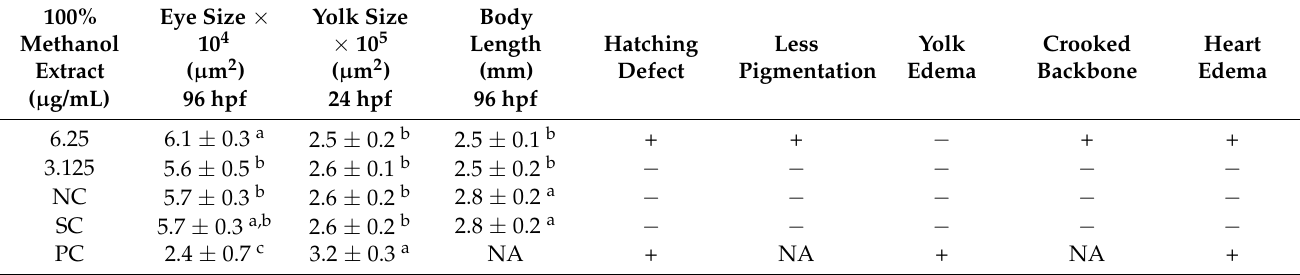
Table 5. Observations of eye size, yolk size, heartbeat, body length, hatching defect, less pigmentation, awkward position, and heart edema of the developing zebrafish embryos treated with six different concentrations of 100% v/v methanol extract of P. malayana